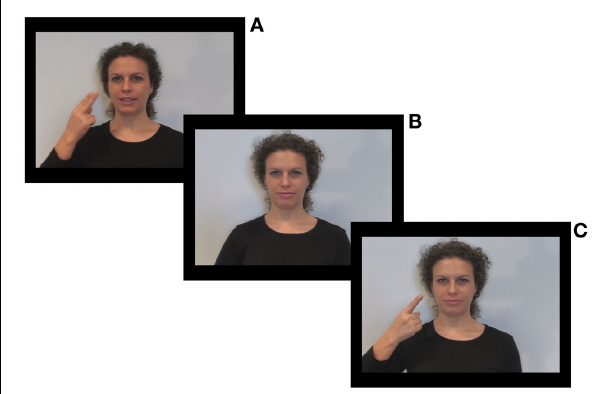
FIGURE 2 | Stimulus sample. Video frame of lip-reading with congruent cue condition (A) , of audio only condition (B) , of audio with congruent cue condition (C)